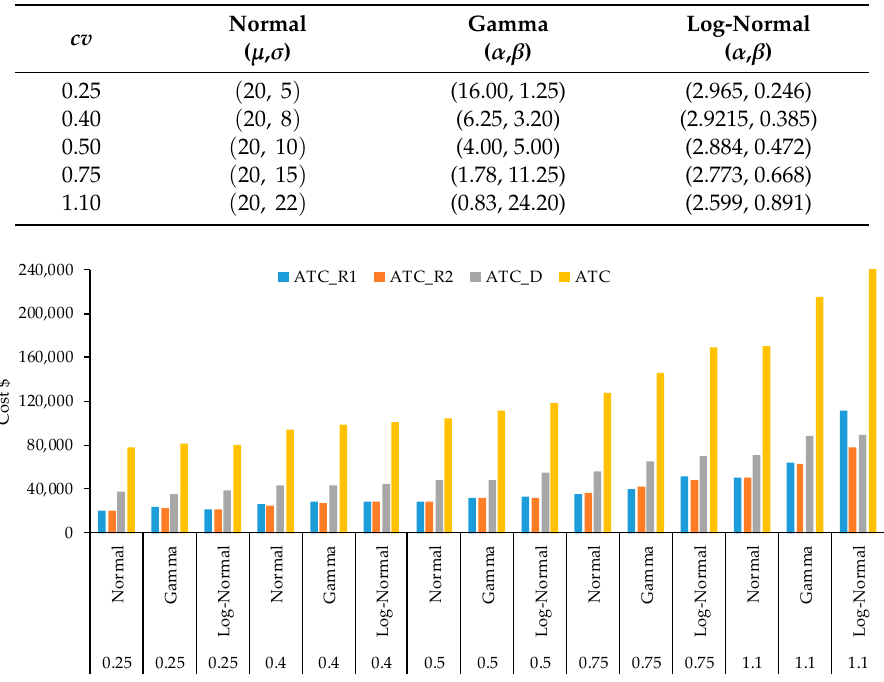
Table 5. The parameters of the three distributions